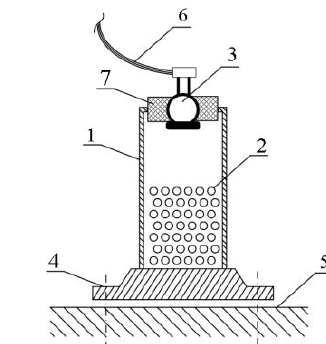
Fig. 5. The sensor of the boundary parameters. Fig. 6. The sensor for assessing Fig. 7. The sensor of integral the dynamic states of the working estimation of dynamic states of medium. the working